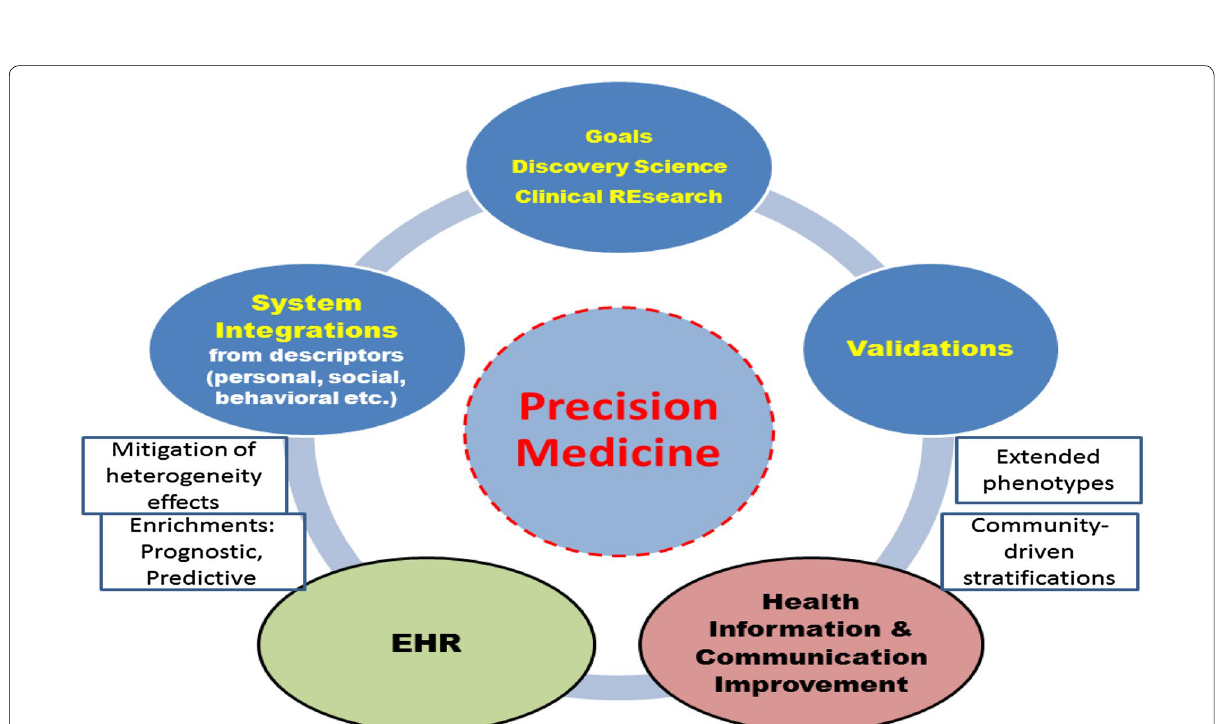
Fig. 2 Multidimensionality remains a characteristic also with a precision medicine